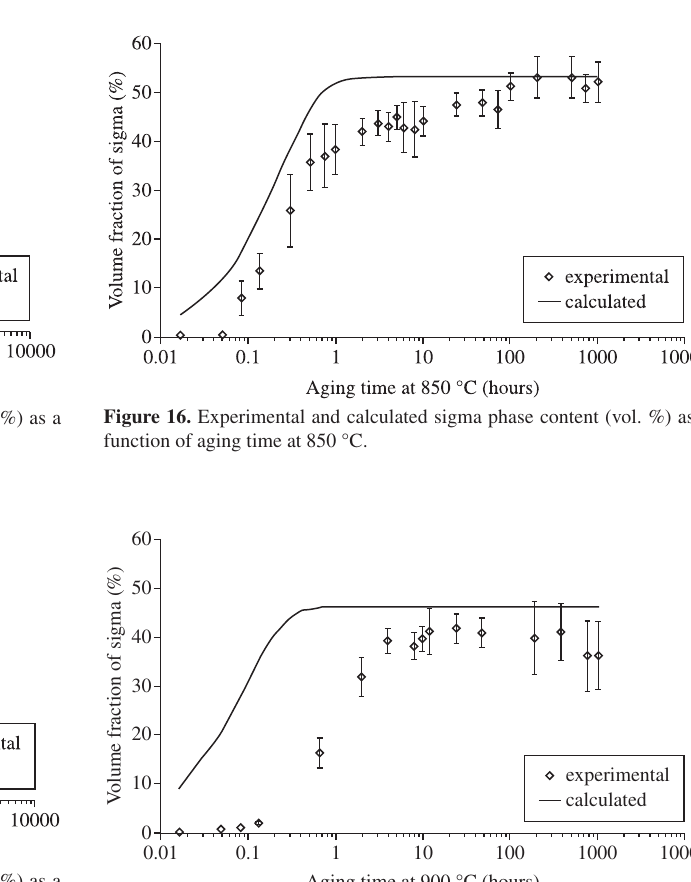
Aging time at 900 °C (hours) Figure 17. Experimental and calculated sigma phase content (vol. %) as a function of aging time at 900 °C.